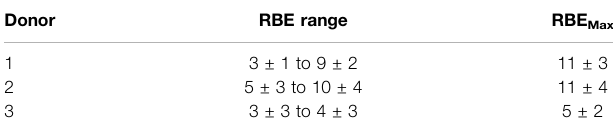
TABLE 3 | The RBE ranges and RBE Max values for 123 I as test radiation and 60 Co as reference radiation. Donor